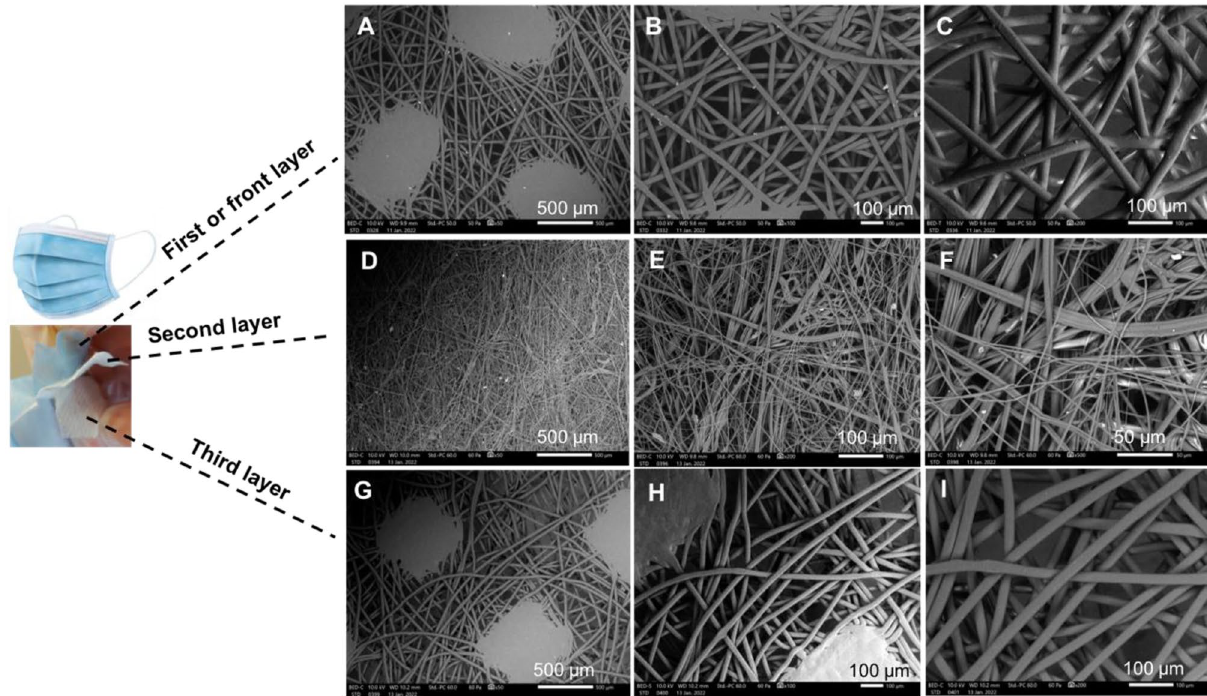
Figure 1. SEM for each of the three layers of a surgical mask. ( A – C ) front layer. ( D – F ) second layer. ( G – I ) third